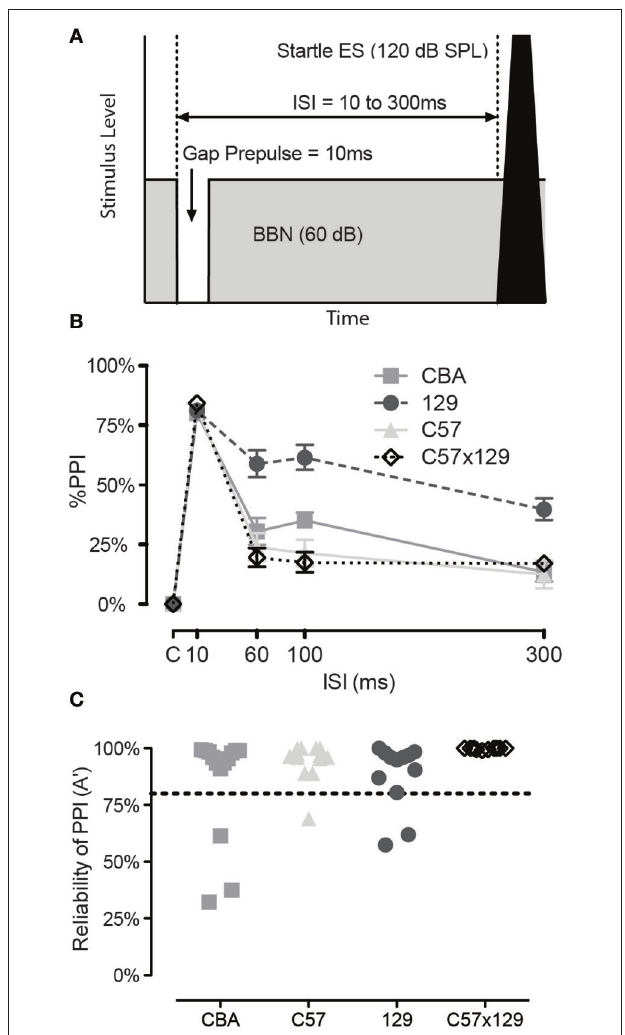
FIGURE 2 | Prepulse inhibition for a gap in otherwise continuous background noise can be used for rejection criteria. (A) Schematic of the acoustic stimuli. The prepulse is a 10ms silent gap that commences 10–300ms prior to the startle stimulus. (B) The gap is a highly effective prepulse in all mice when presented at 10ms lead-time before the ASR. Strains vary by how effective the prepulse is beyond 10ms, though the response is stable between 60 and 100ms. (C) Criterion for rejecting individual mice. If the non-parametric A ′ measure was less than 80% for the 10ms gap condition, the mouse would be rejected as an unreliable responder. Strains varied in the proportion of rejected animals. Error bars are